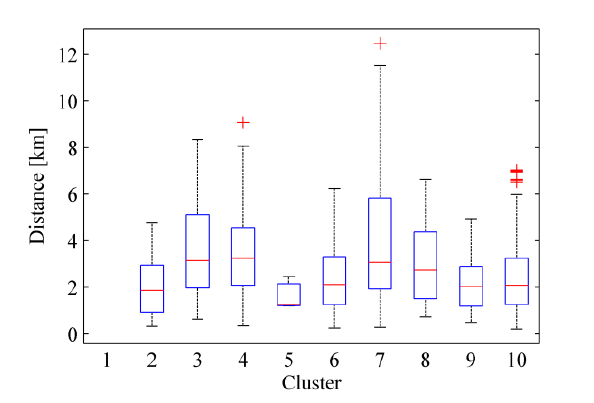
Figure 5. Decreasing behavior of cost function